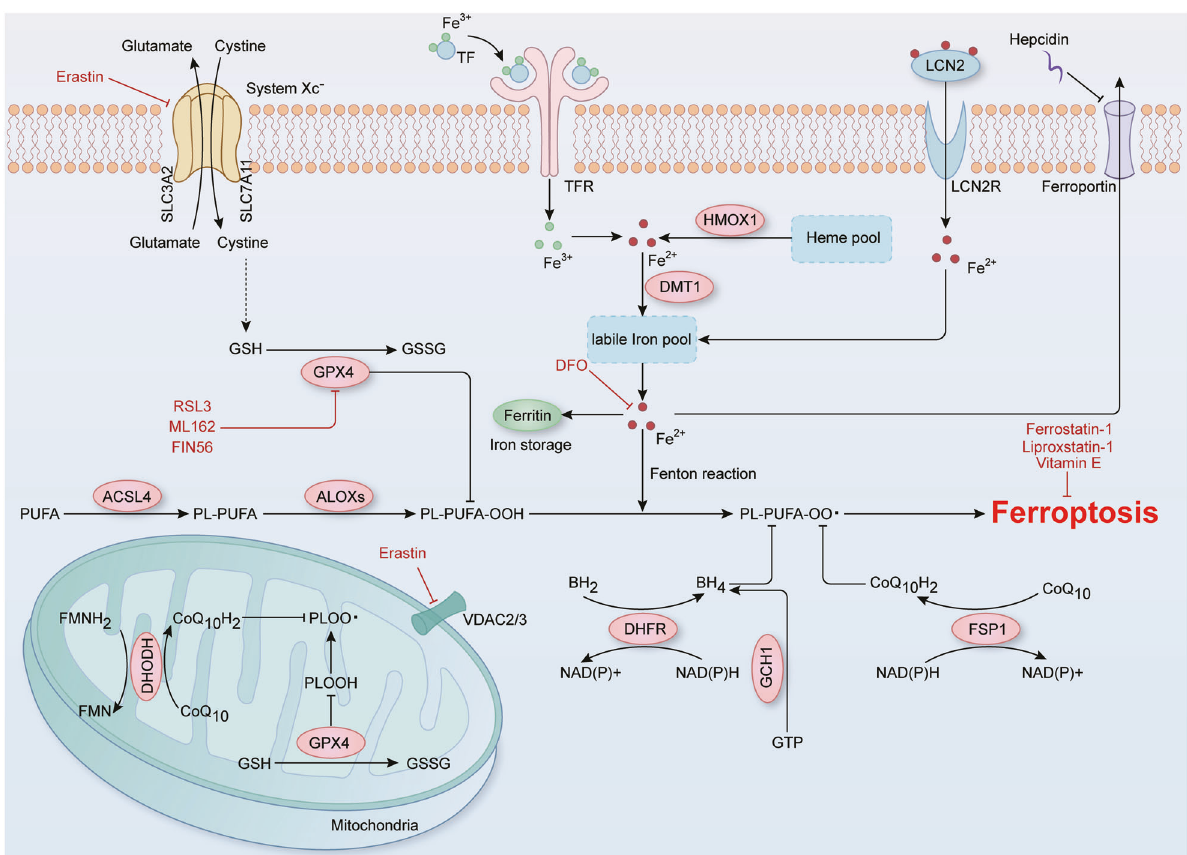
Fig. 1 The mechanisms of ferroptosis. Iron-mediated lipid peroxidation is the core process in ferroptosis. In brief, TF and LCN2 carry extracellular iron and transfer it into cell via their corresponding receptors, while intracellular iron is mainly exported by ferroportin to maintain iron homeostasis. In the cells, HMOX1 degrades heme to release free iron, whereas the iron storage protein ferritin limits intracellular iron utilization to prevent iron overload and ferroptosis. As a catalyst, ferrous iron converts peroxides into free radicals such as hydroxyl and hydroperoxyl